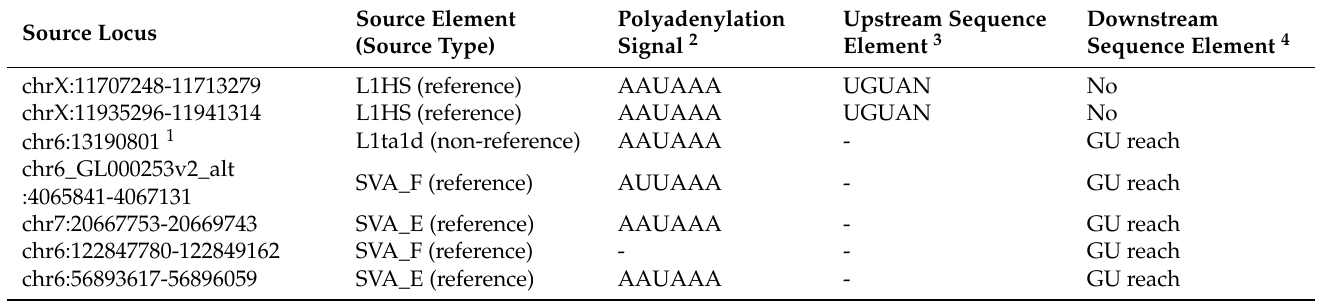
Table 5. Structural features of the 3 (cid:48) end of the most prolific identified donor loci in this study. Source